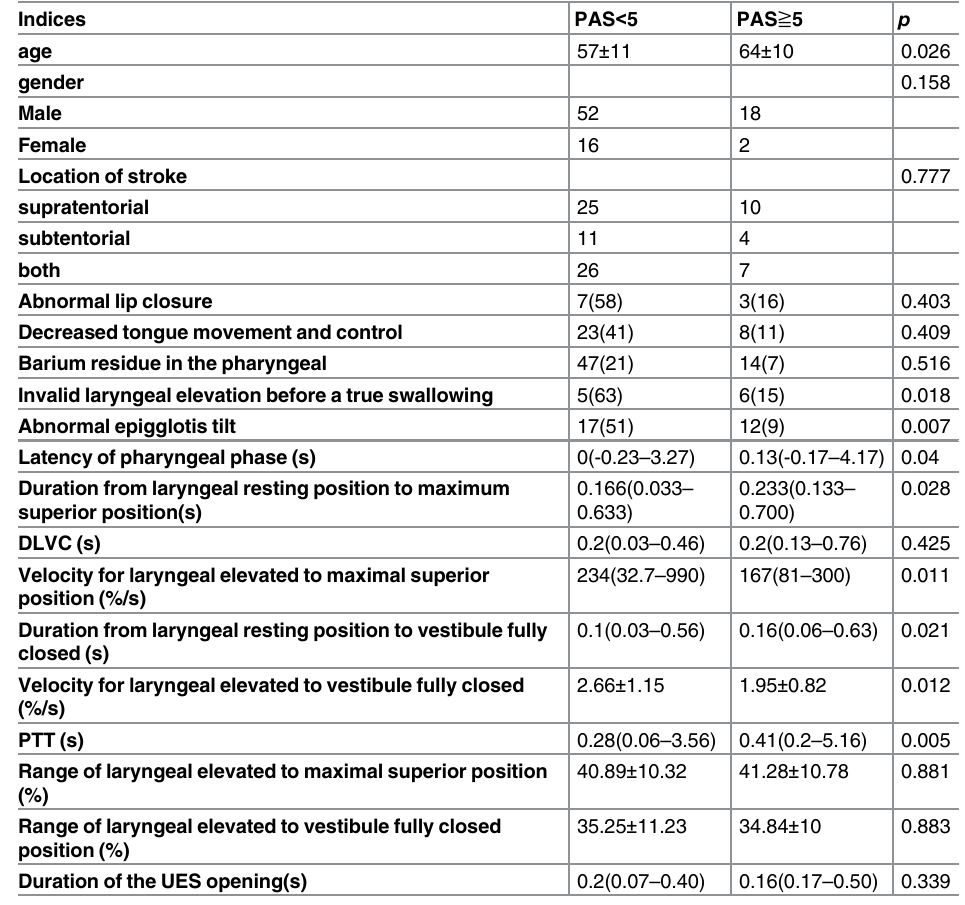
Table 1. Baseline demographic and clinical information and comparison of the VFS indices in patients using univariate analysis with PAS equal to or greater than 5 and less than 5.